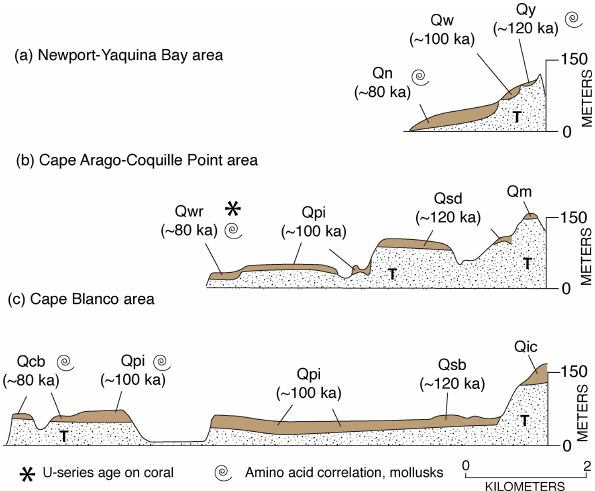
Figure 19. Cross sections of marine terrace deposits in coastal Ore- gon in the Newport-Yaquina Bay area (a) , Cape Arago–Coquille Point area (b) , and Cape Blanco area (c) , as well as estimated ages based on U-series dating of corals, amino acid geochronology of mollusks, and degree of soil development. Cross sections from Kelsey et al. (1996) for (a) , McInelly and Kelsey (1990) for (b) , and Kelsey (1990) for (c) ; geochronological data from Kennedy et al. (1982), Muhs et al. (1990, 2006), and Kelsey et al. (1996). De- posit abbreviations as defined in Fig. 18 caption.